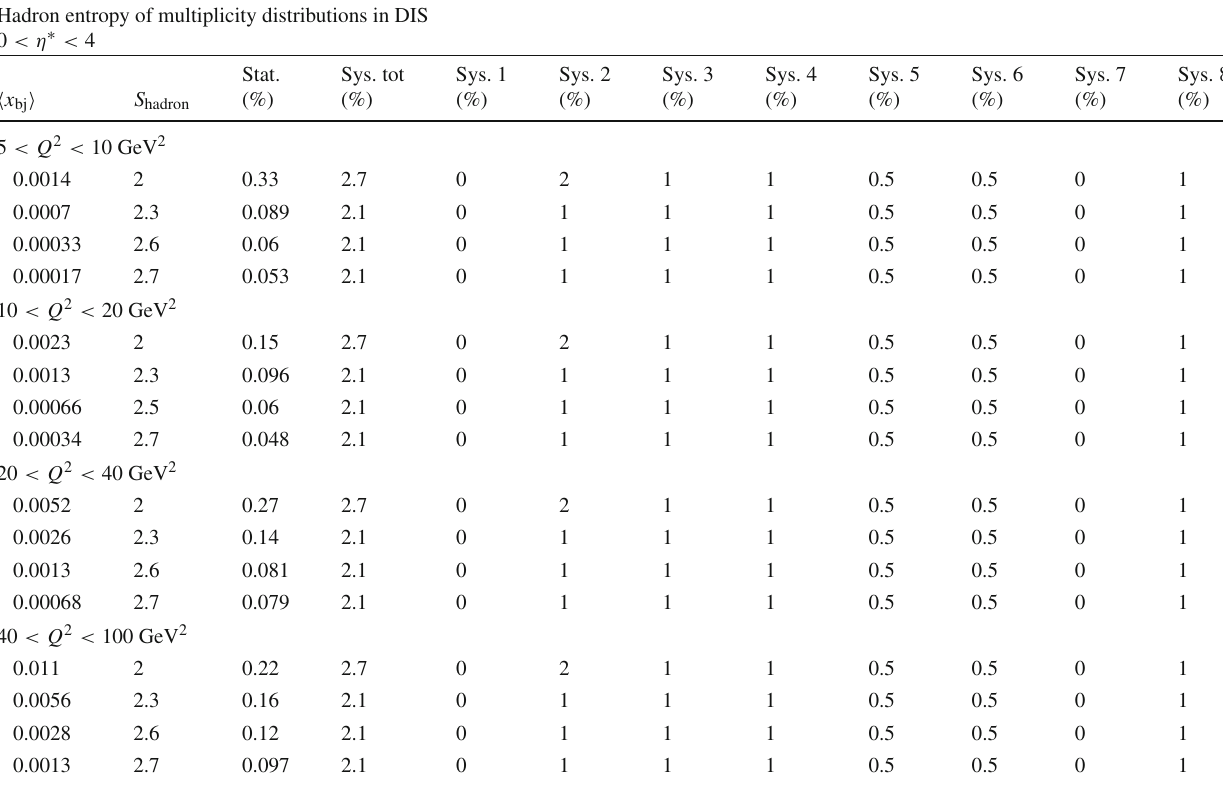
is further restricted as shown in Table 1. For this dataset, the entropy is determined with the track pseudorapidities in the hadronic centre-of- mass frame are restricted to the range 0 < η ∗ < 4